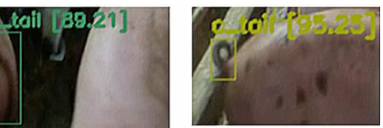
Figure 8. Images from the video showing the detection precision of curved and straight tails from YOLOv4 object